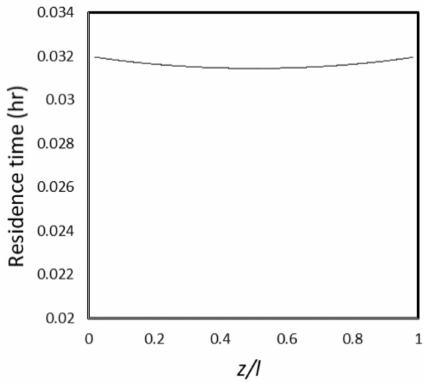
Figure 5. Residence time within a cuboid packed-bed as function of dimensionless length ( z / l ) (media: Capto Q, dimensions: 58.9 mm length × 12 mm width × 12.7 mm bed height, bed volume: 9 mL, Flow rate: 5 mL/min, superficial velocity = 42 cm/h).